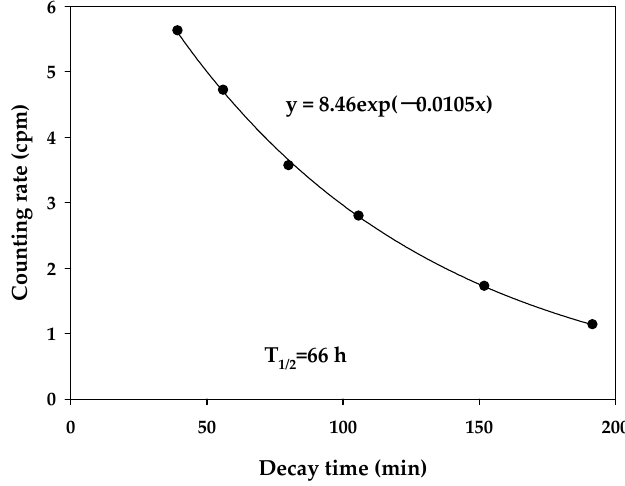
Figure 4. Decay curve of the squid samples based on the described analytical procedure. Table 4. Results obtained for two standard samples (uncertainties are expressed at k =